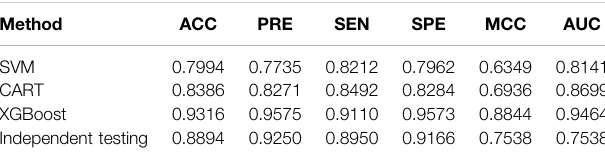
TABLE 2 | Performance of XGBoost in comparison with other classi fi ers on the combination feature set. Method